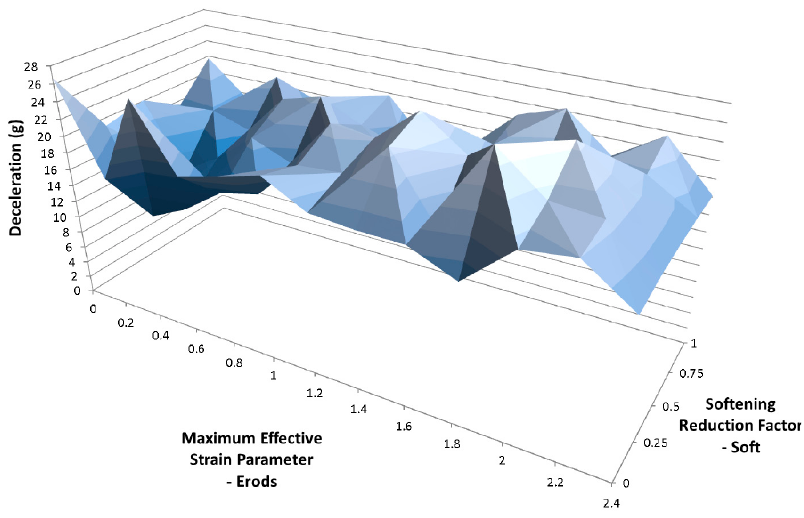
Figure 12. Effect of Erods parameter and Soft factor with All Slim = 1.0, TSize = 1 × 10 − 11 and FS = 1.0.